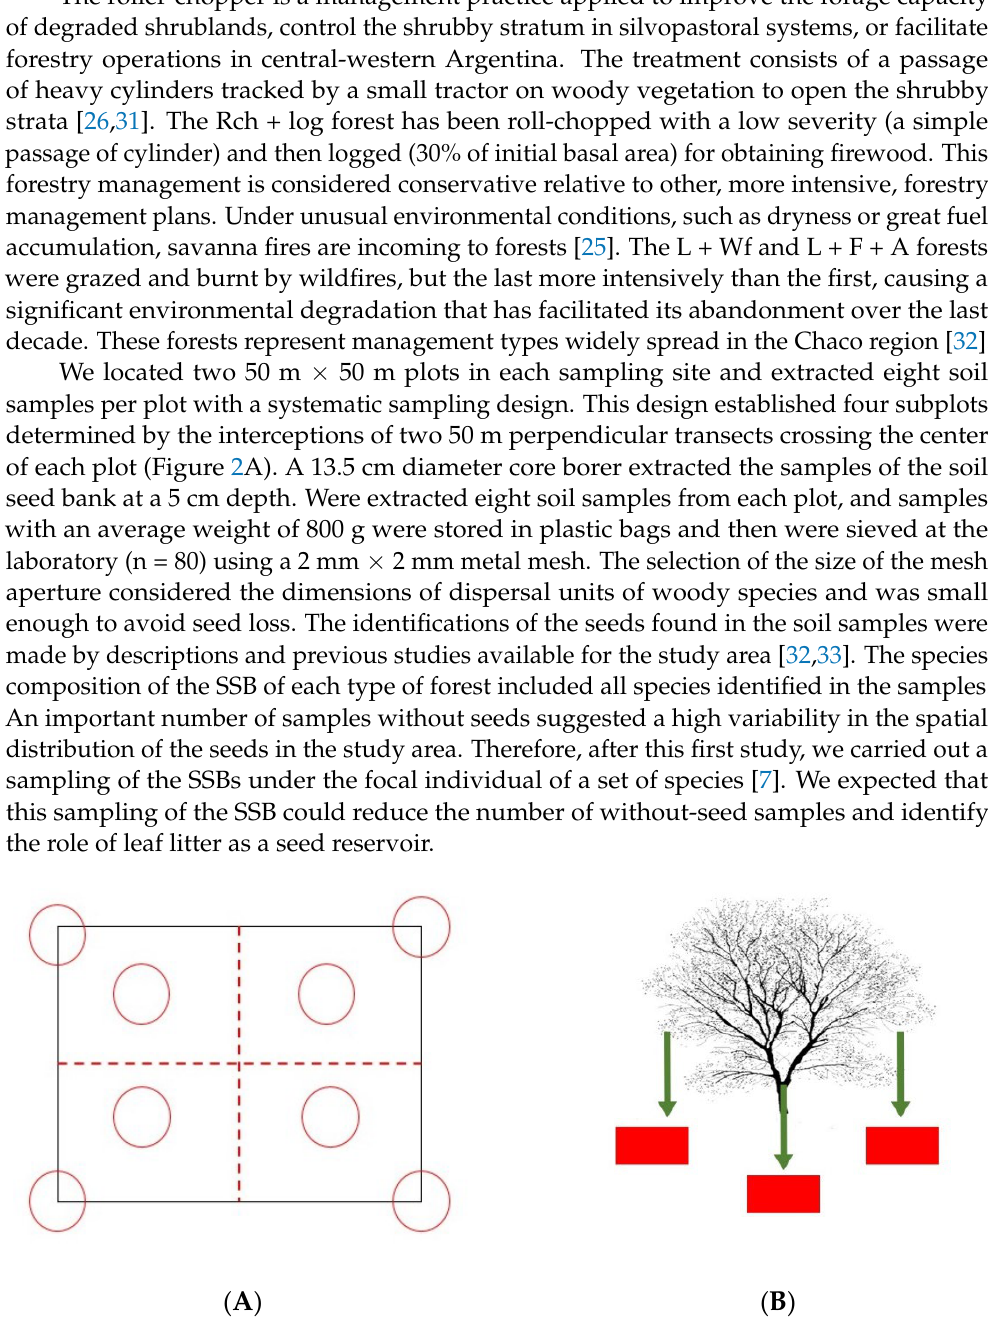
Figure 2. Sampling design of soil seed banks in Chaco-region forests, Argentina ( A ). Diagram of the soil samples extraction following the systematic sampling design ( B ). Localization of soil samples extracted under focal individuals.